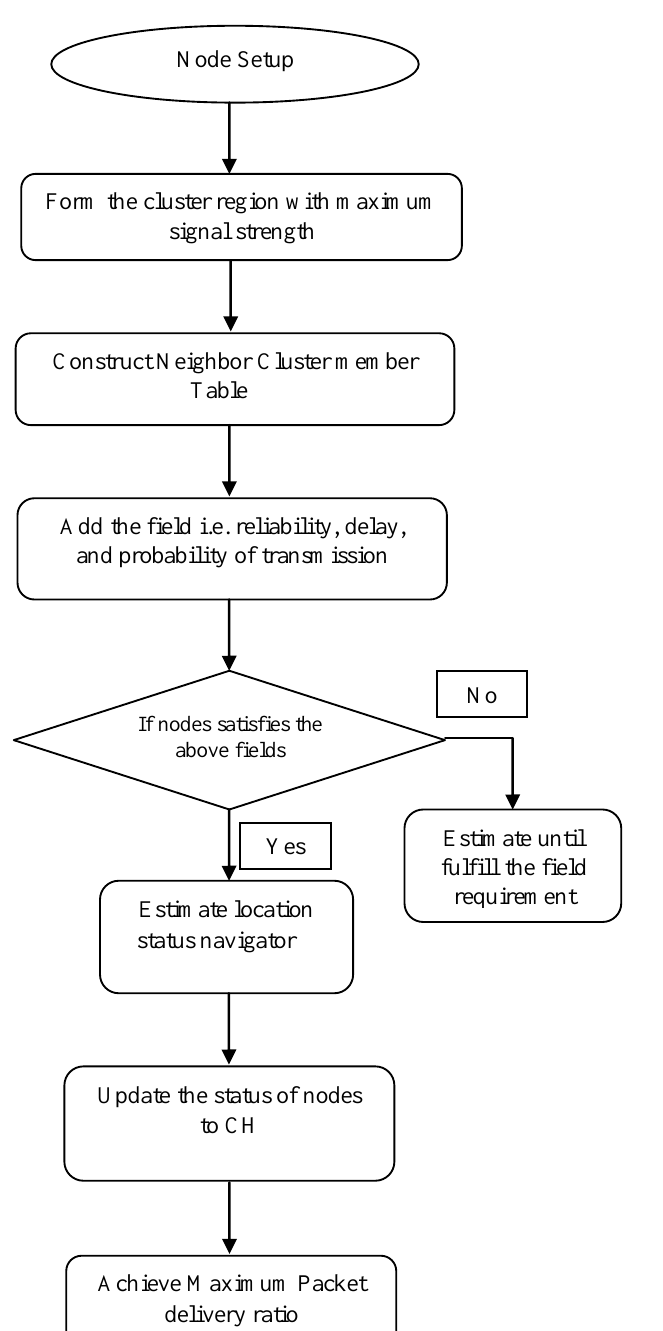
Figure 2. Flowchart of NCLAR